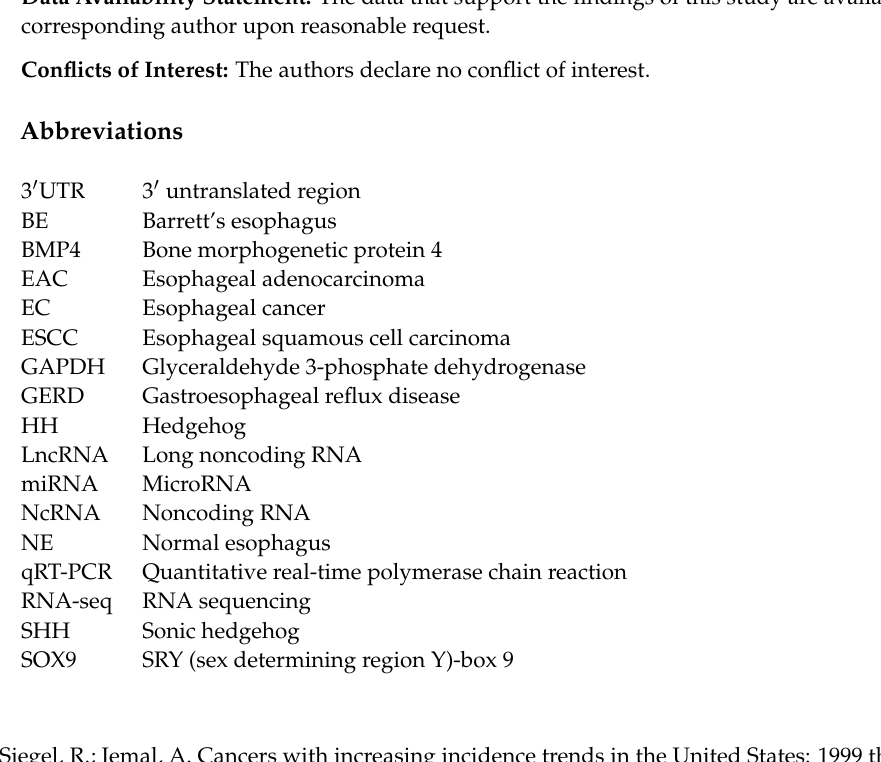
Figure S2: PTCH1 expression in NE-BE tissue